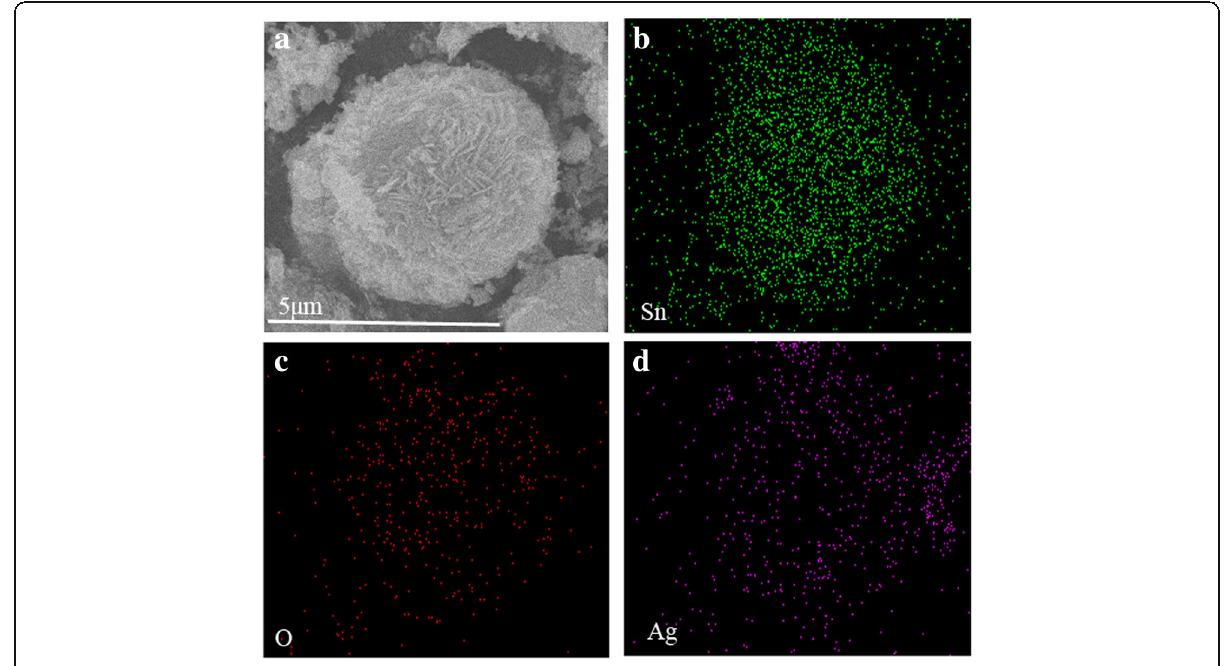
Fig. 3 EDS element mapping of SnO 2 /Ag microspheres. a SEM image and element maps of b Sn, c O, and d